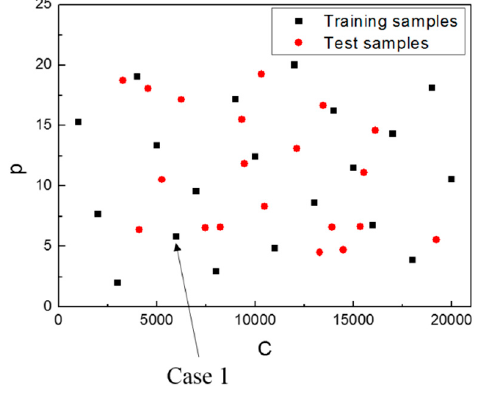
Figure 4. Training and test samples used for the construction of the surrogate model. Table 1. LS-DYNA keywords used in EHF simulation.